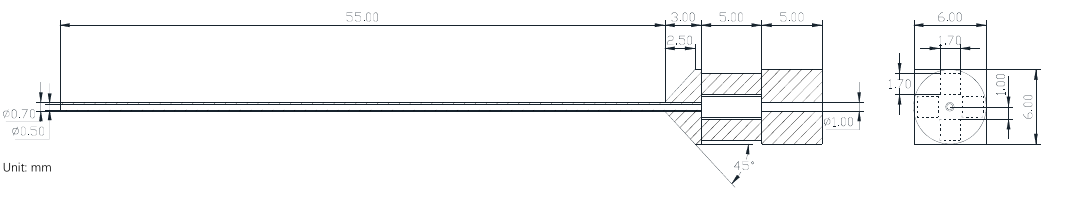
Figure 4. First three orders of transverse vibration displacement response curves.